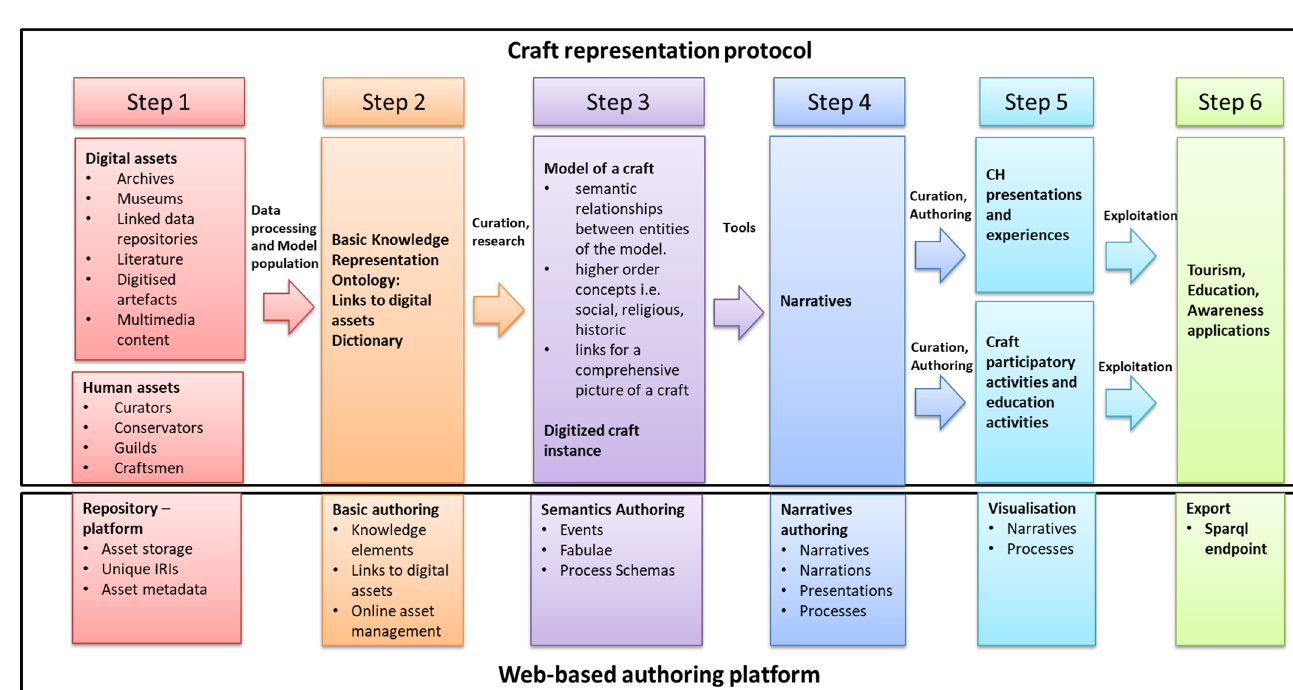
Figure 1. Illustration of protocol steps.